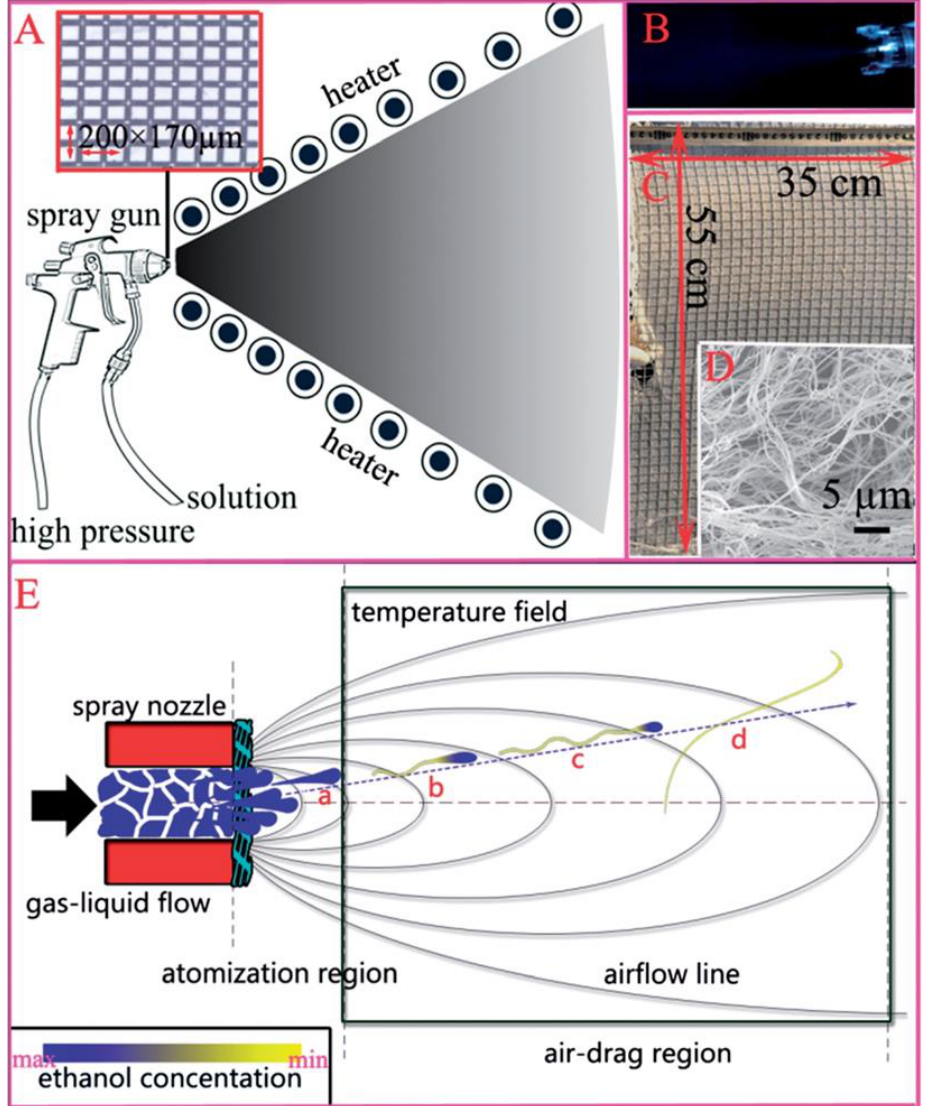
Figure 5. High-pressure gas spinning. ( A ) The simple and novel droplet-elongating spinning instrument. The spray gun was connected to an air compressor. The nozzle facing the temperature fi eld (60 º C) was equipped with a 200 mesh fi lter. ( B ) A high-speed digital image of the droplet-elongating spinning process in action. ( C ) Image of PVP nano fi ber membrane of area 35 × 55 cm 2 after 15 min spinning 450 mL PVP solution, showing the ultrahigh productivity of the extrusion spray spinning. ( D ) Scanning electron micrograph showing the uniform nano fi bers distributed randomly. ( E ) Schematic illustration of the droplet-elongating spinning process: (a) pear-like droplet; (b) and (c) the tadpolelike droplet ‘‘wagging its tail’’ and its body being elongated; (d) small diameter fi bers (Reprinted with permission from Ref. [29]. 2012 Royal Society of Chemistry).